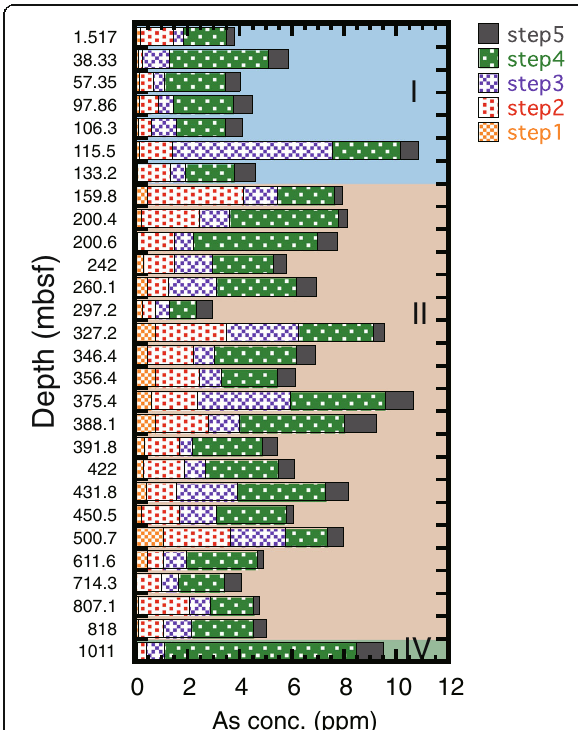
Fig. 4 Sequentially extracted arsenic concentrations of the sediments of Site C0002, Kumano Basin, Nankai Trough